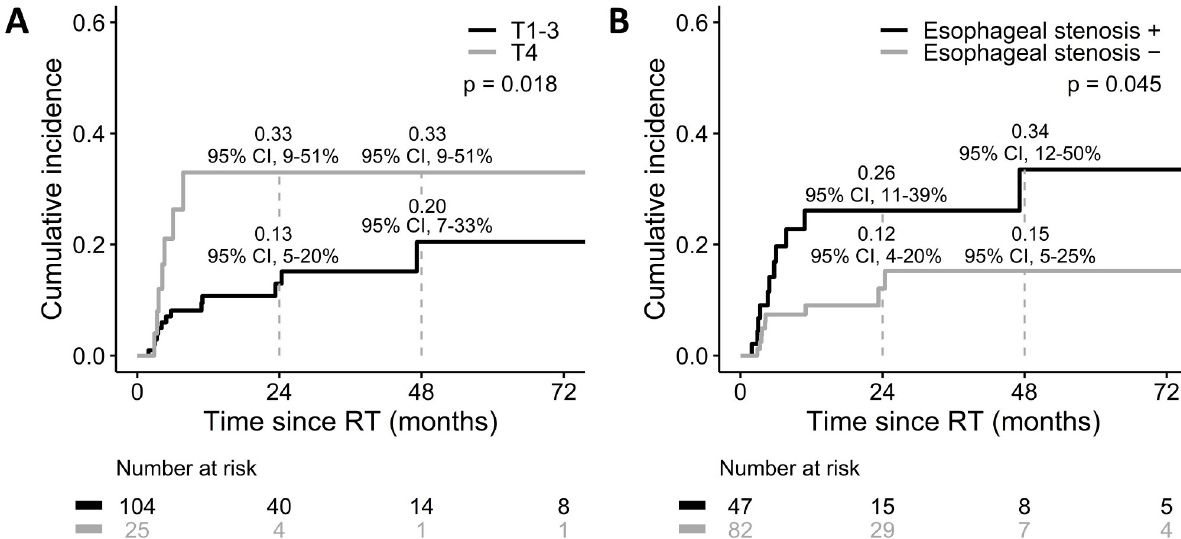
Fig 2. Cumulative incidence of esophageal fistula by (A) T stage and (B) esophageal stenosis .